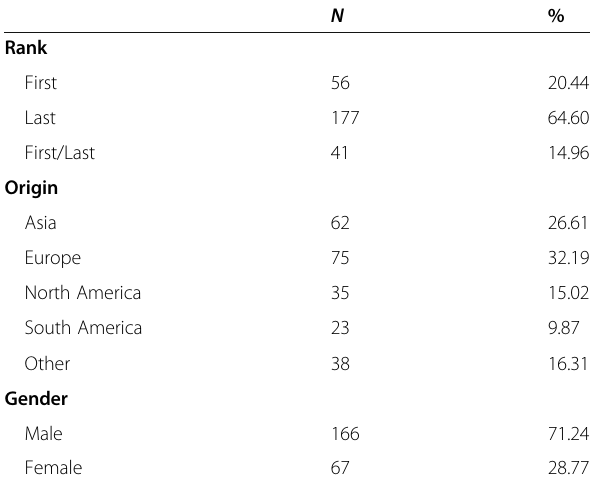
Table 2 Distribution of the self-citing authors per rank, origin, and gender. The rank “ First/Last ” refers to articles where an equal number of self-citations were observed for first and last